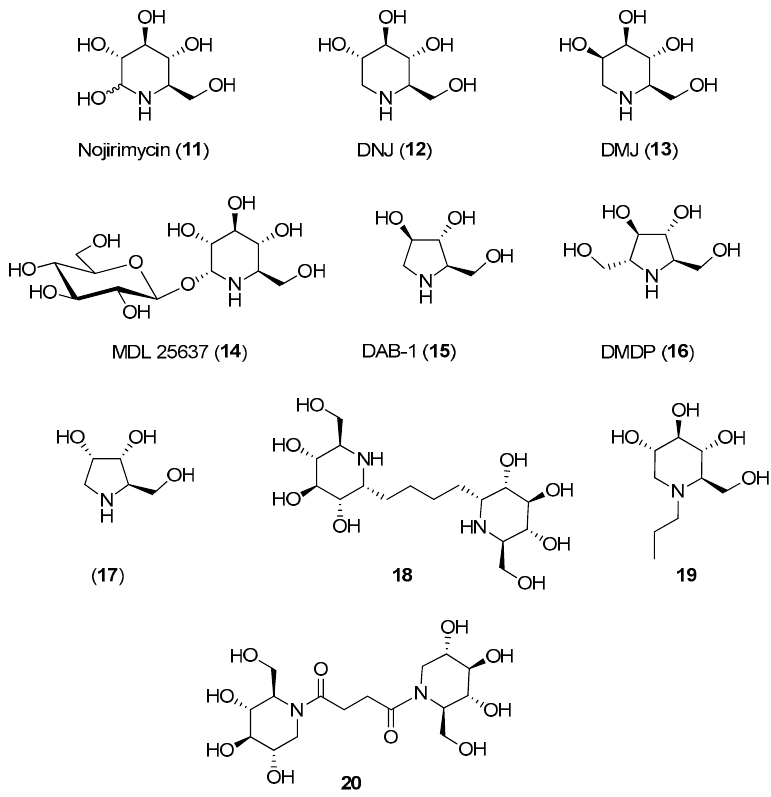
Figure 3. Structures of monocyclic iminosugar-based trehalase inhibitors and their derivatives.